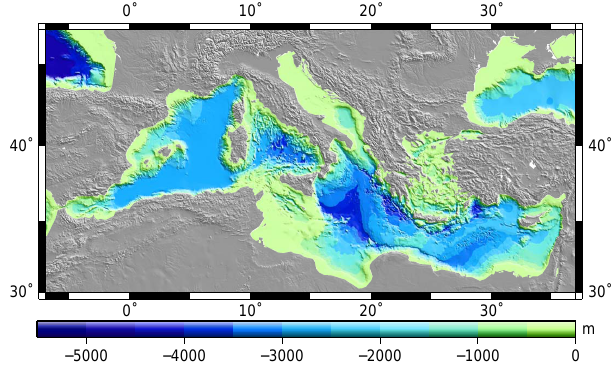
Fig. 1. Bathymetry in the Mediterranean